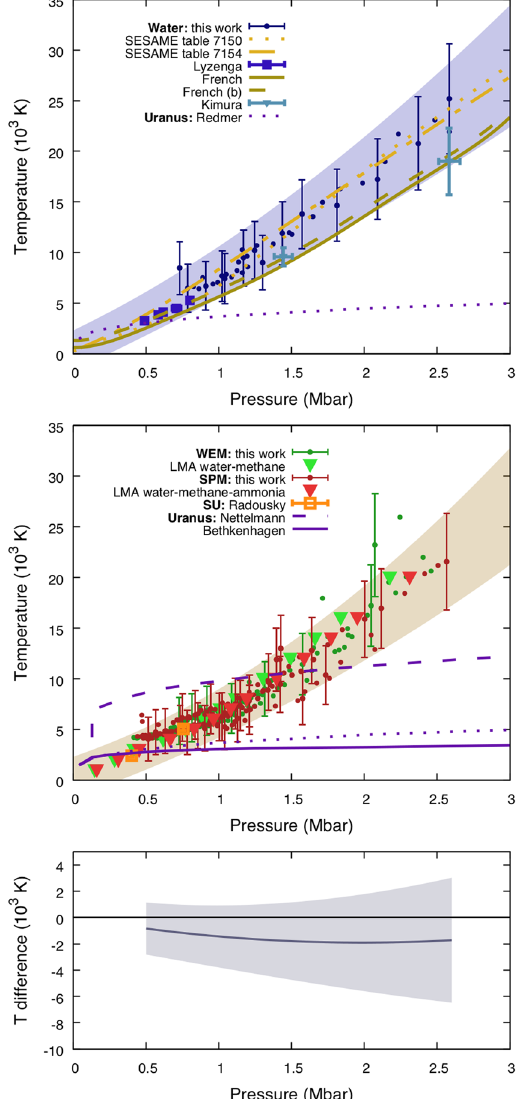
Figure 3. From top to bottom: temperature - pressure relation for pure water (blue data) along the principal Hugoniot curve; the same relation for the WEM (green data) and the SPM (red data); temperature difference between the fit on mixtures and the fit on pure water. Each filled circle is a time-resolved measure during the propagation of a decaying shock. Each area corresponds to the error bars of the associated fit. Previous studies of pure water 24,27,46,54 and synthetic Uranus 21 are shown for comparison. Different Uranus interior models 20,52,53 are shown in